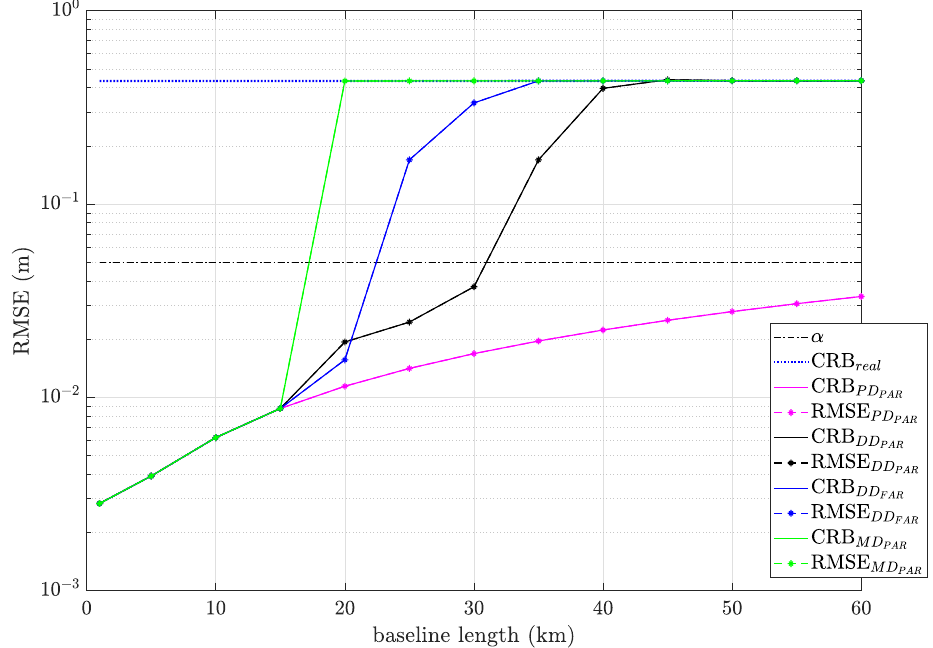
Figure 7. RMSE for each ambiguity resolution scheme vs baseline